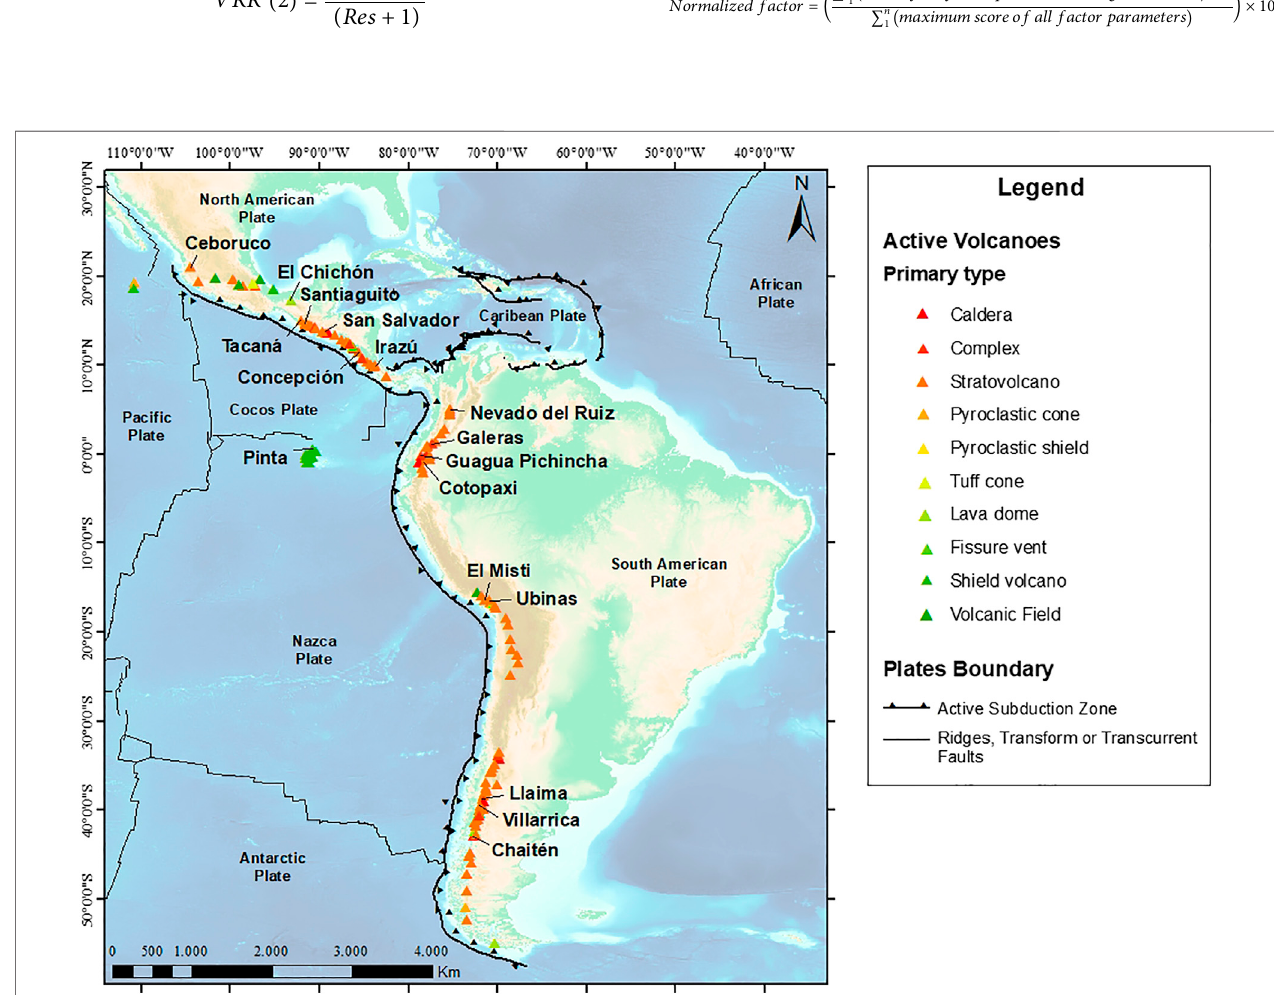
FIGURE 3 | Location of the studied volcanoes in Latin America, with recorded activity in the past 1,000 years, classi fi ed according to their primary type (data from Global Volcanism Program (GVP) database, Smithsonian Institution, https://volcano.si.edu). The volcanic systems with highest VRR (1) scores of each country and the volcanic system with lowest VRR score (Pinta) are indicated. Base map reproduced from the GEBCO global bathymetric grid 2021, www.gebco.net.